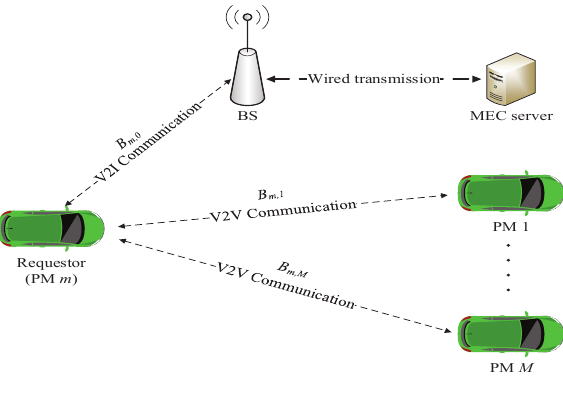
Figure 2. Task offloading system